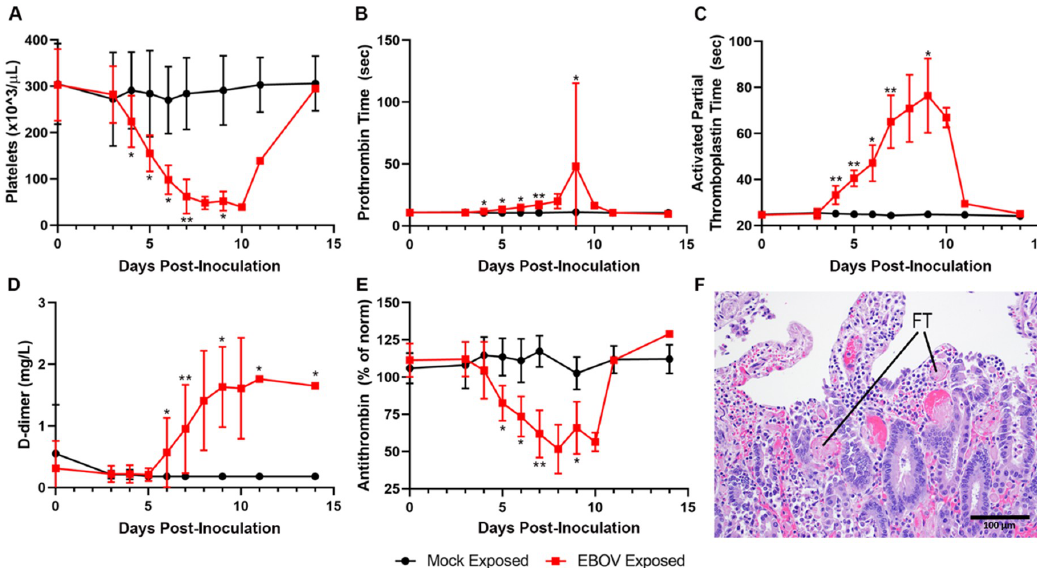
Figure 7. Exposure to IM EBOV in rhesus macaques produces clinical pathology and histological alterations indicative of coagulopathy, including disseminated intravascular coagulopathy. Group means ± SD of: platelets ( A ); prothrombin time ( B ); activated partial thromboplastin time ( C ); d-dimer ( D ); and antithrombin ( E ). X-axes are truncated to highlight responses occurring from the first sampling point through the acute disease phase. * p < 0.05; ** p < 0.001. p -values are indicated for comparison of change-from-baseline values in mock- vs. EBOV-exposed animals on the indicated study day. ( F) Small intestine, duodenal mucosa showing numerous intravascular fibrin thrombi (FT, two representative examples noted).